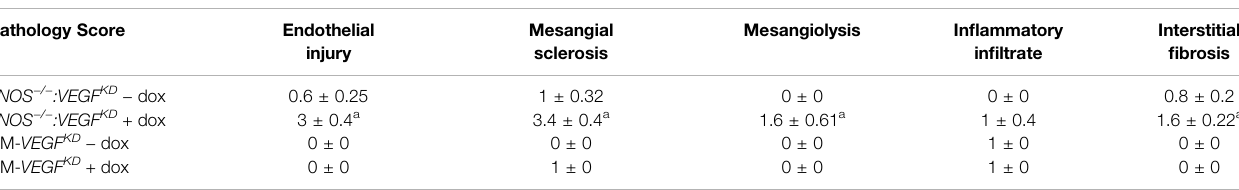
TABLE 2 | Pathology score. Pathology